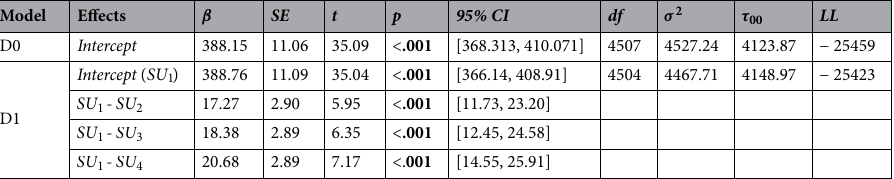
2 variance of level-1 residual errors, τ 00 variance of level-2